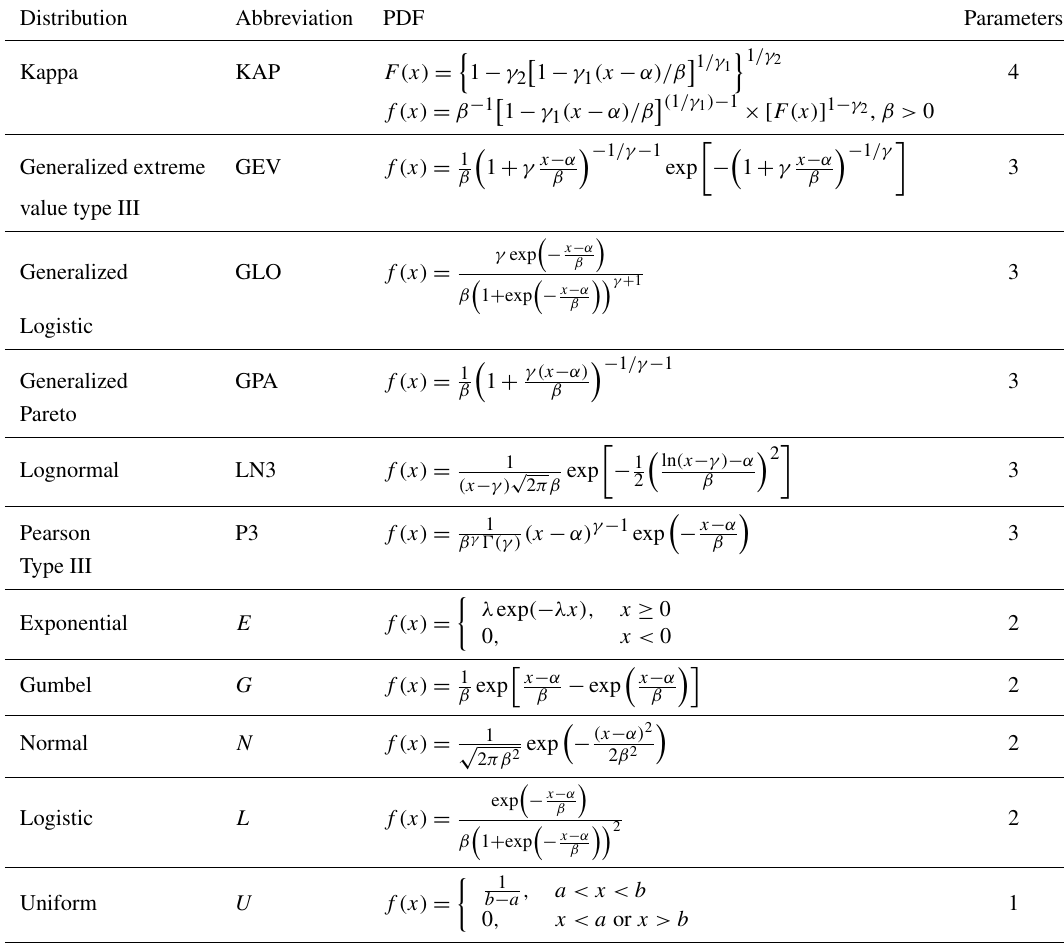
Table 2. Theoretical probability distributions presented on the L-kurtosis vs. L-skew L-moment diagram. Distribution